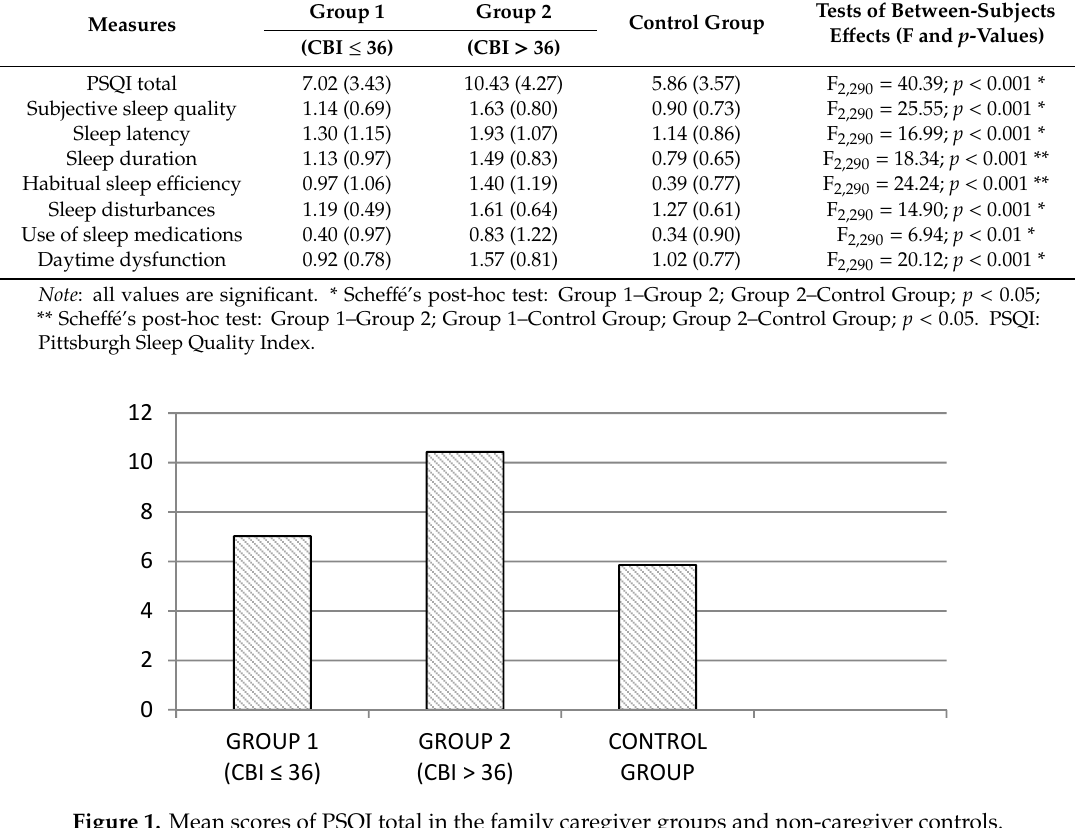
Figure 1. Mean scores of PSQI total in the family caregiver groups and non-caregiver controls.